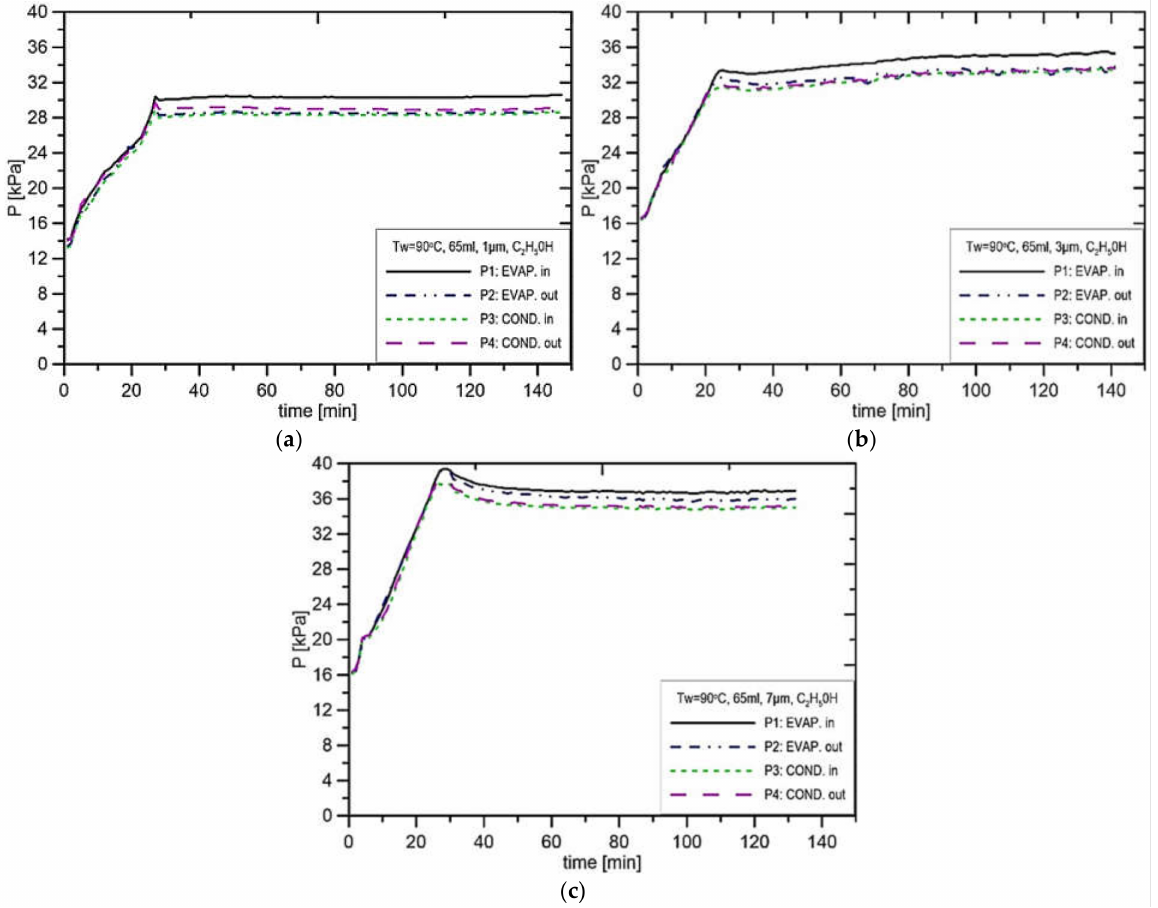
Figure 13. Distribution of pressure in function of time when using ethanol, charge volume 65 mL, T w = 90 ◦ C, ( a ) R = 1 µ m, ( b ) R p = 3 µ m, ( c ) R p = 7 µ